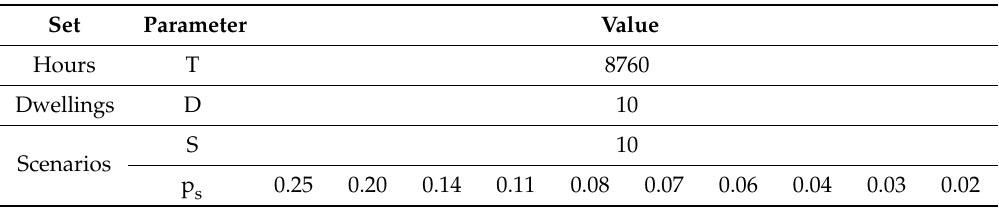
Table 12. Parameters of the